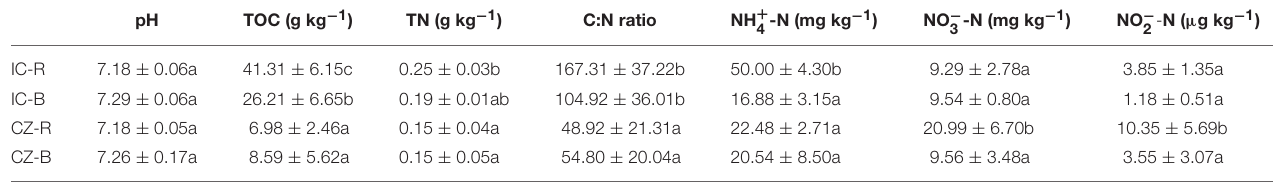
TABLE 3 | Soil basic chemical properties of bulk tailings and rhizospheric samples of Imperata cylindrica and Chrysopogon zizanioides ; lowercase letters indicate significant differences in each column (LSD, P < 0.05). pH